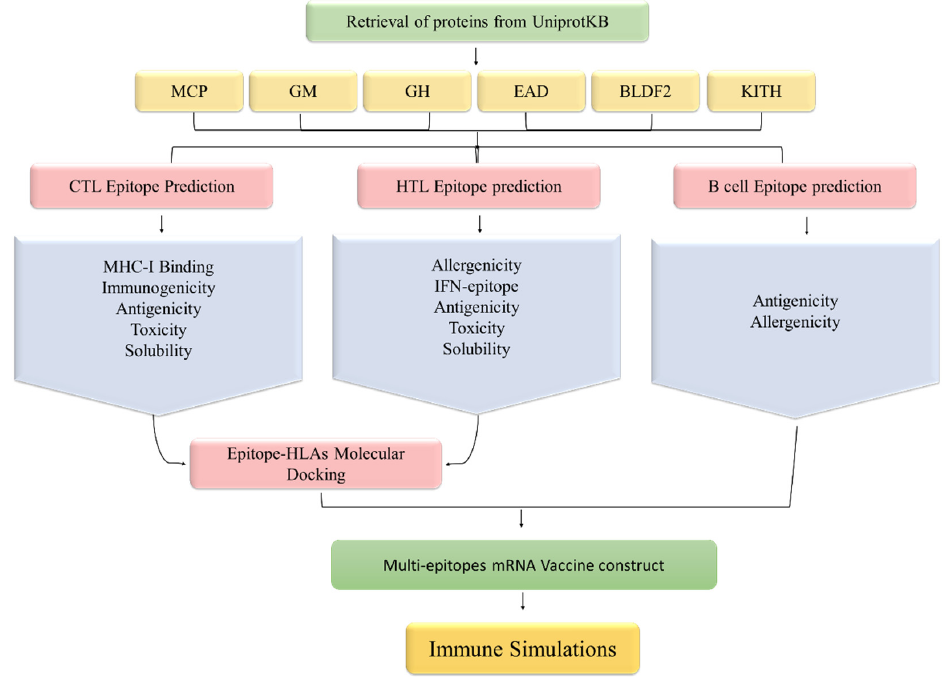
Figure 1. Methodological workflow of designing an mRNA vaccine against EBV in this